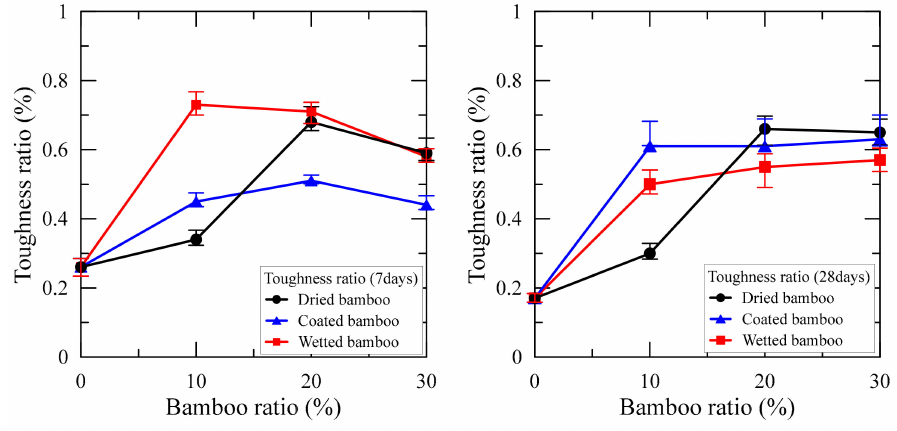
Figure 6. Toughness ratio of the specimens with di ff erent bamboo